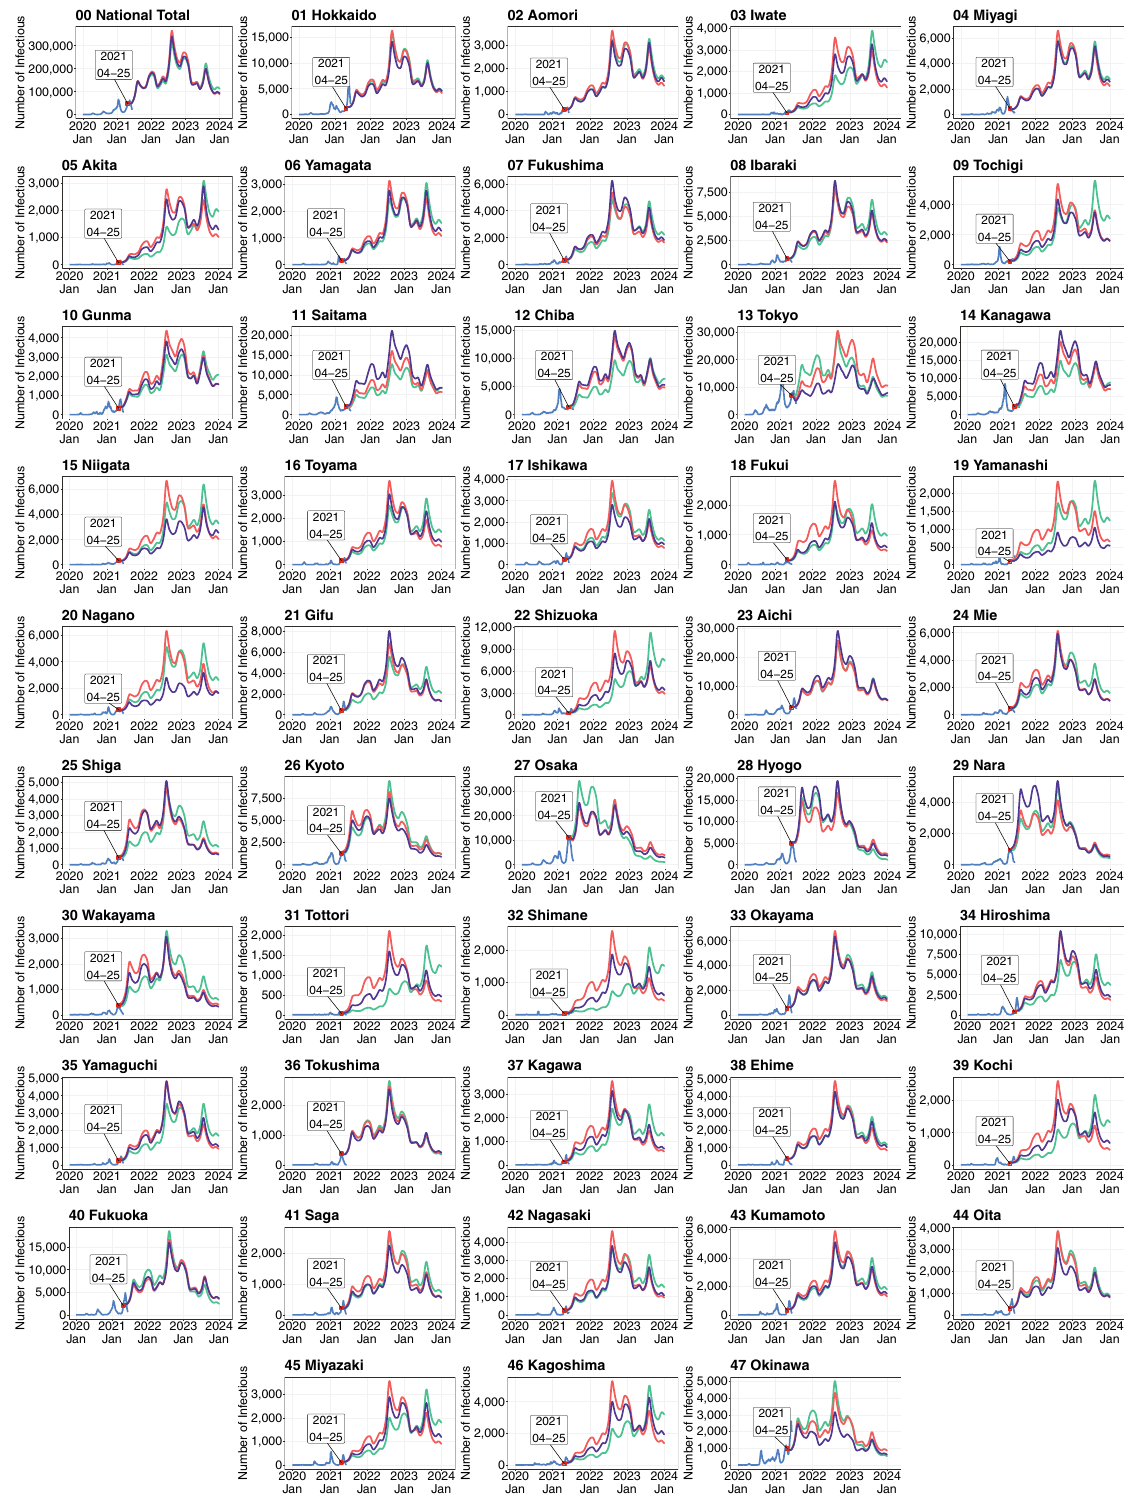
Figure 7. Simulated numbers of infectious people by prefecture under the assumptions that the government either does or does not restrict the interregional mobility of infectious people to remain in their residential prefectures. Shown are the observed numbers of infectious people up to April 25, 2021 (blue lines), the numbers of infectious people simulated by the spatial SEIR model without interregional mobility (green lines), and those simulated by the spatial SEIR model with interregional mobility, assuming that the interregional mobility of only infectious people is restricted (purple lines) or that free mobility across prefectures is allowed for all individuals (red lines). The simulations were started on April 25,